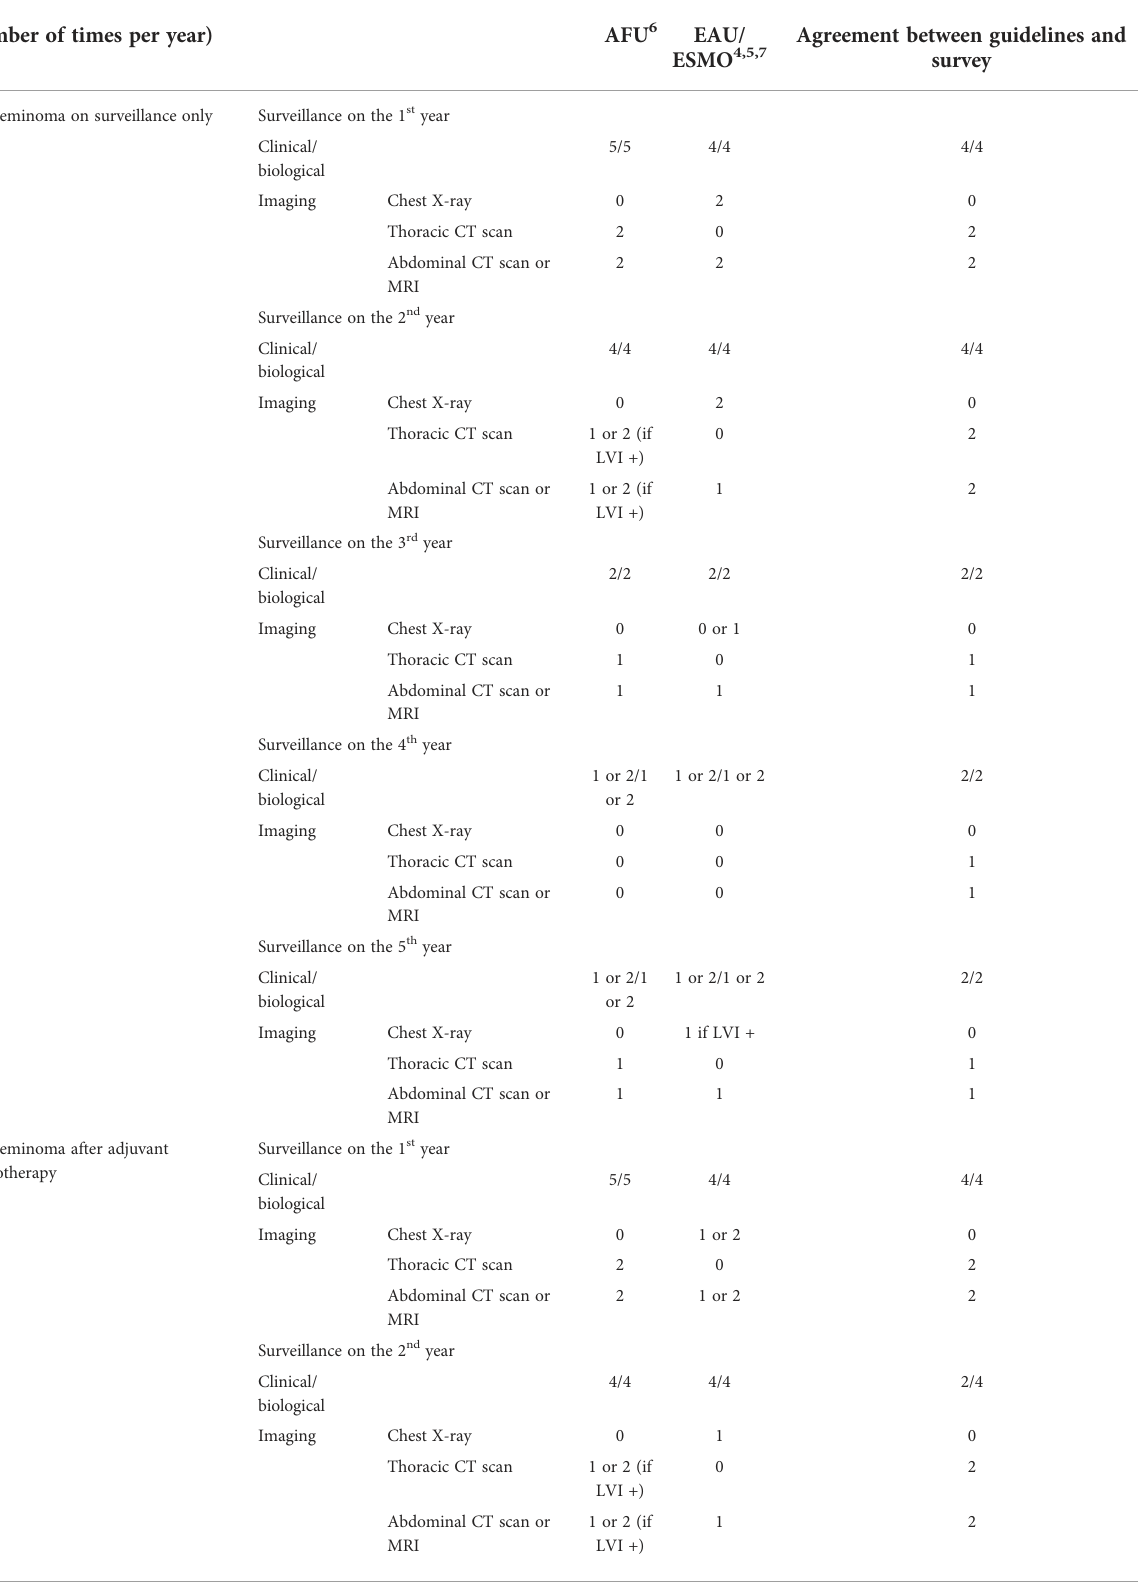
Agreement between guidelines and ESMO 4,5,7 survey